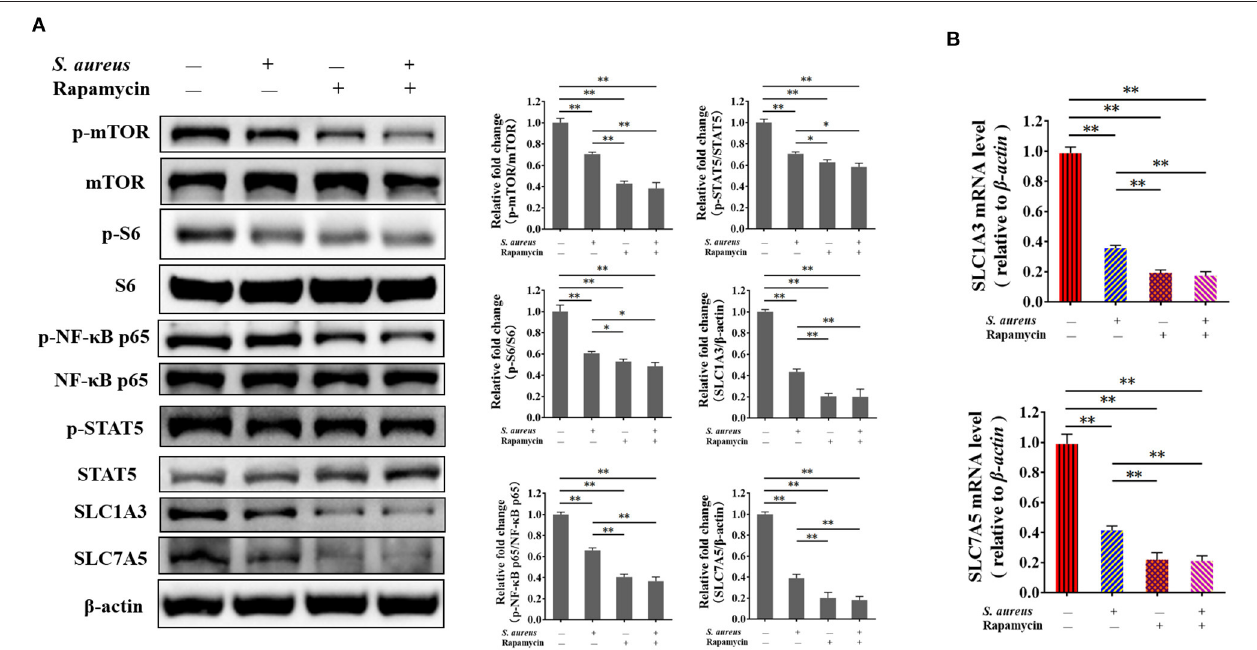
FIGURE 7 | Inhibition of mTORC1 by S. aureus infection and rapamycin attenuates the phosphorylation of NF- κ B p65 and STAT5 and the expression of SLC1A3 and SLC7A5. The phosphorylation of mTOR, S6, NF- κ B p65, and STAT5 was detected by western blot, and SLC1A3 and SLC7A5 were examined by RT-qPCR and western blot. (A) Phosphorylation of mTOR, S6, NF- κ B p65, and STAT5 and levels of SLC1A3 and SLC7A5 in different BMECs treatment groups. (B) mRNA levels of SLC1A3 and SLC7A5 in different BMECs treatment groups. mTORC1 pathway was inhibited during S. aureus infection. The resolved bands were quantified using